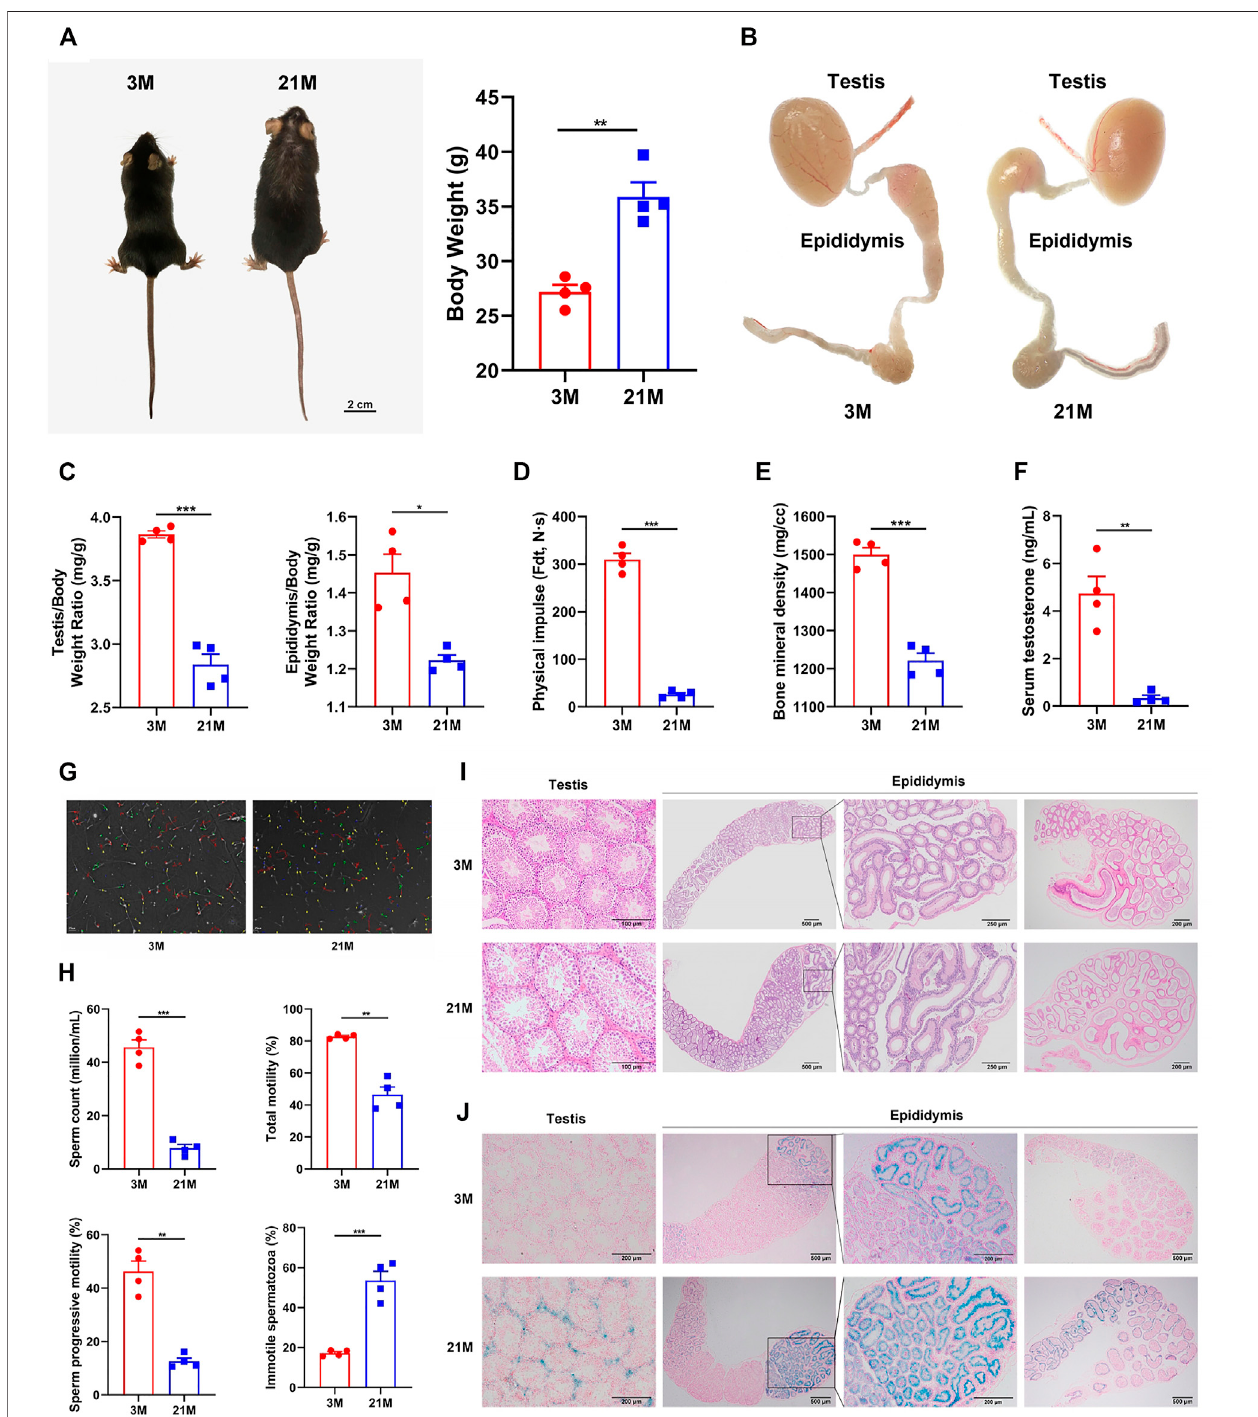
FIGURE 1 | Phenotypicand histological analyses of reproductive and systemic aging in male mice. (A) Physical appearance and body weight of mice of 3-months and 21-month. (B) Male reproductive organs in mice of different ages. (C) Organ indices of the testis and epididymis at different ages. (D) Muscle strength of limbs calculated by physical impulse, (E) bone mineral density of the femur, (F) serum testosterone concentration, and (G – H) epididymal sperm concentration and motility between young and old mice. (I) Representative hematoxylin and eosin staining of testis and epididymis. (J) Representative β -Galactosidase staining of the testis and epididymis. Strong positive staining was detected in the testicular interstitium (lower left panels), the initial segment of epididymis, and a small area of the caput epididymidis connected to the initial segment (lower right panels) in aged mice. Weak positive staining was detected in the epithelium of the corpus epididymidis (lower right panels) and was barely observed in the cauda epididymidis (lower right panels, the far-right picture). All experiments were performed in at least 4 independent replicates. * p < 0.05, ** p < 0.01, *** p < 0.001; 3 M: 3-months; 21 M: 21-months.